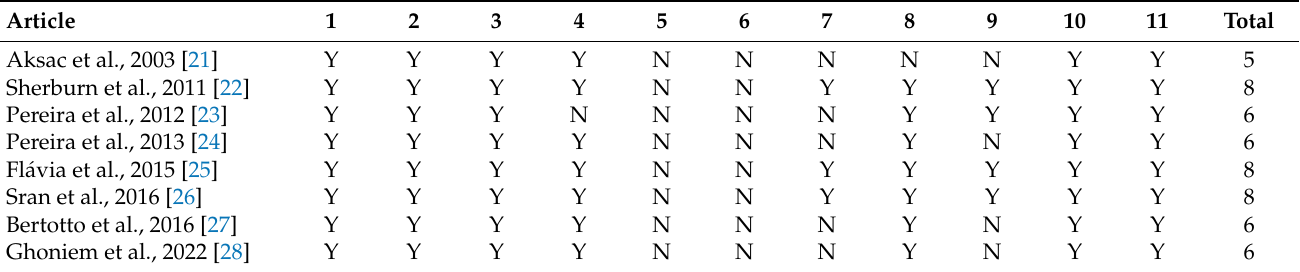
Table 1. Methodological quality of the articles